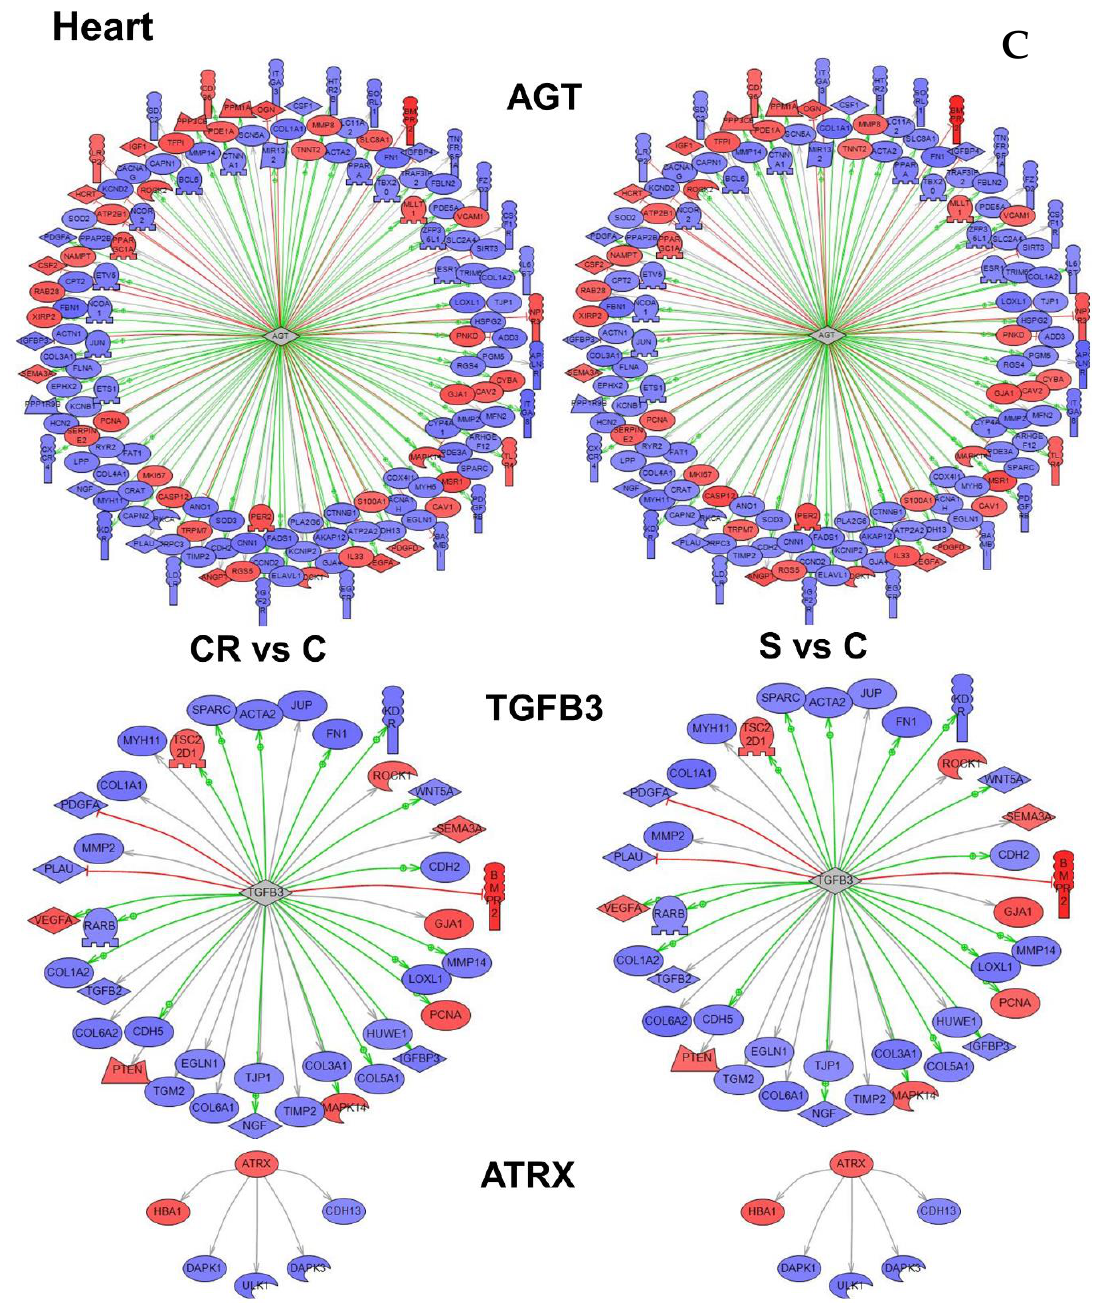
Figure 4. ( A ) Subnetworks enrichment analysis for upstream regulators of expression classified for overlap or p -value in brain cortex. The regulators are shown as nodes with downstream interactions indicated by edges. Colors correspond to a level of expression (blue is underexpression and red is overexpression). Color of the edges corresponds to a type of regulation of expression. Green is known positive regulation, red is known negative regulation and grey is a direct regulation, but unknown effect. Representative subnetworks of the overlap or p -value are shown. ( B ) Subnetworks enrichment analysis for upstream regulators of expression classified for overlap or p -value in skeletal muscle. The regulators are shown as nodes with downstream interactions indicated by edges. Colors correspond to a level of expression (blue is underexpression and red is overexpression). The color of the edges corresponds to a type of regulation of expression. Green is known positive regulation, red is known negative regulation and grey is a direct regulation, but unknown effect. Representative subnetworks of the overlap or p -value are shown. ( C ) Subnetworks enrichment analysis for upstream regulators of expression classified for overlap or p -value in heart. The regulators are shown as nodes with